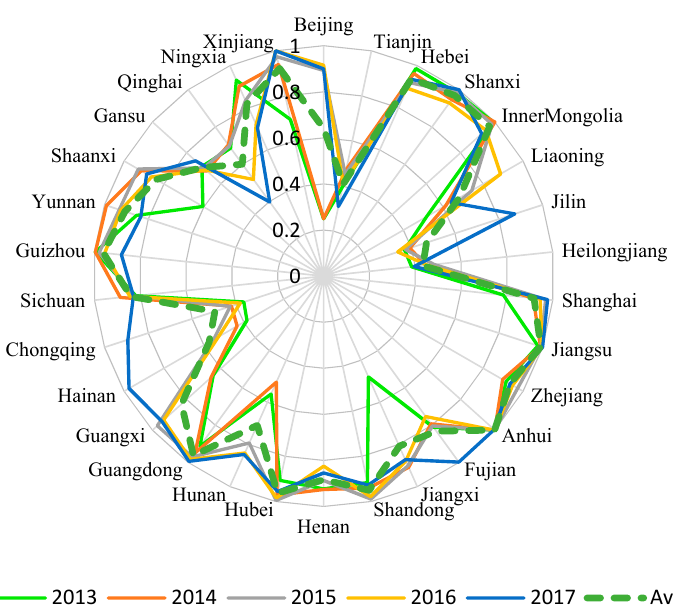
Figure 5. Game cross-efficiency of the 30 regions from 2013 to 2017.